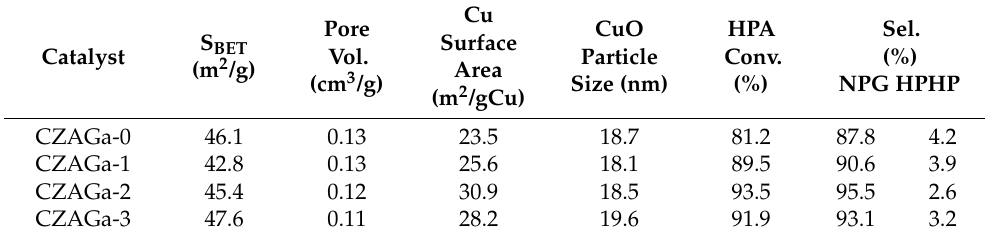
Table 1. Activities and physicochemical properties of different catalysts.